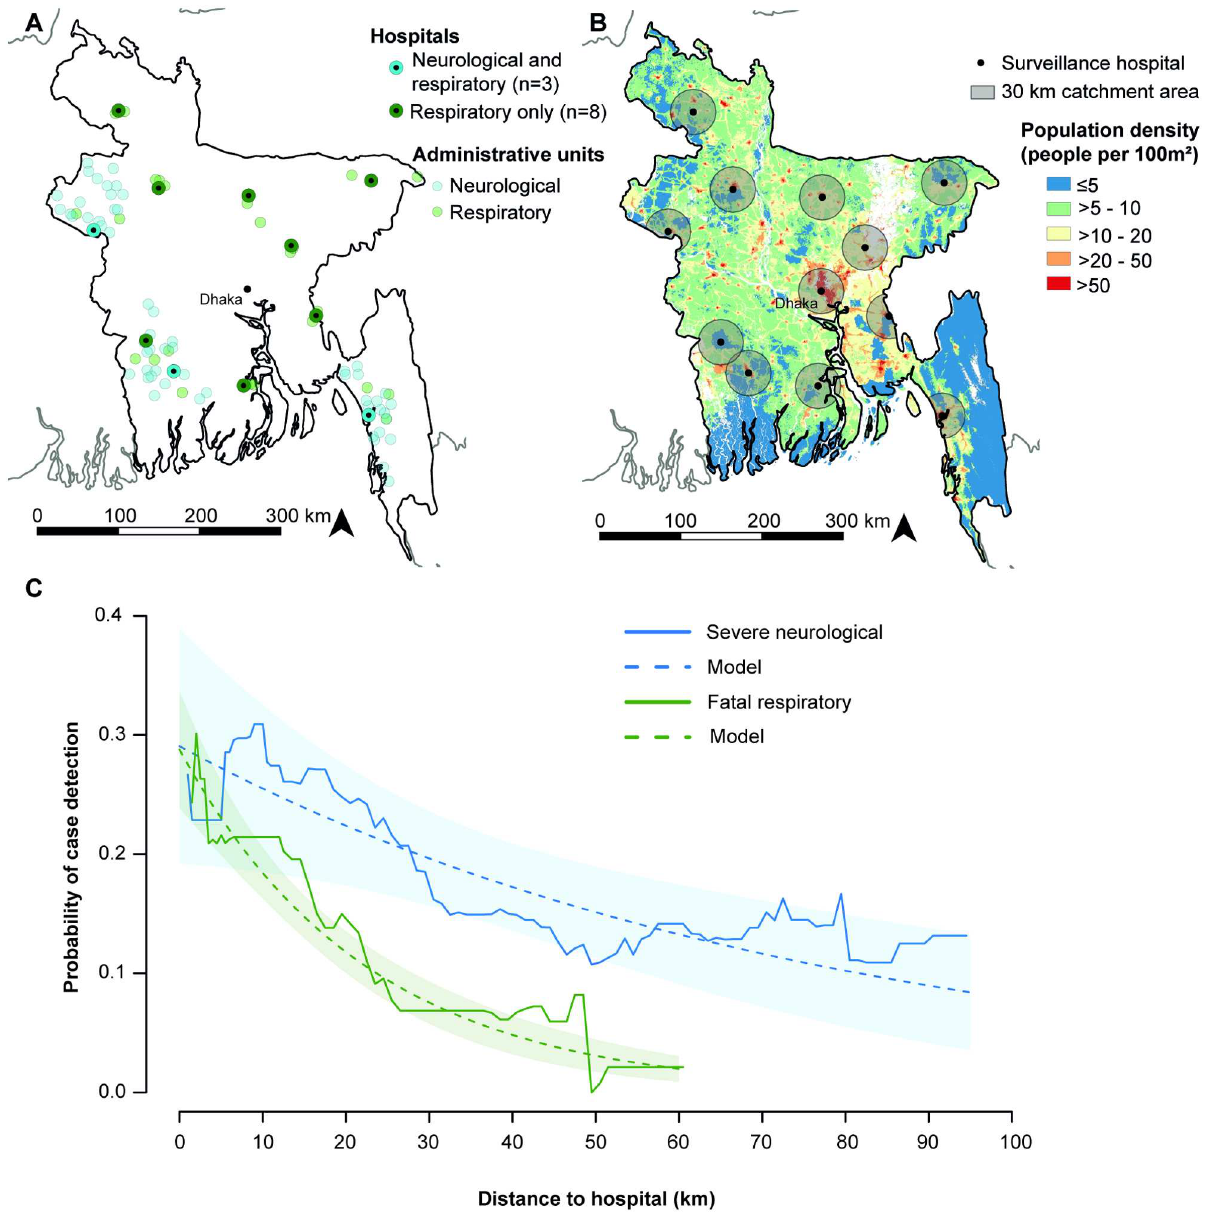
Fig 2. Location of administrative units and casedetection probabilities by distance. (A) Location of surveillance hospitalsand administrative units. The hospitalin Dhaka City was excludedfrom the originalstudies. (B) Populationdensity map of Bangladesh [16]. Sixty-eight percent of the populationin Bangladeshlives > 30 km from a surveillance hospital (including the Dhaka surveillance hospital), a distanceat which case and outbreak detectionprobabilities are low. (C) Probabilityof surveillance case detectionby distance. The observed probabilitywas calculatedas a moving averageover a 25 km distancewindow. Case detectionprobabilities were estimated using log- binomial regression models includingdistanceas an